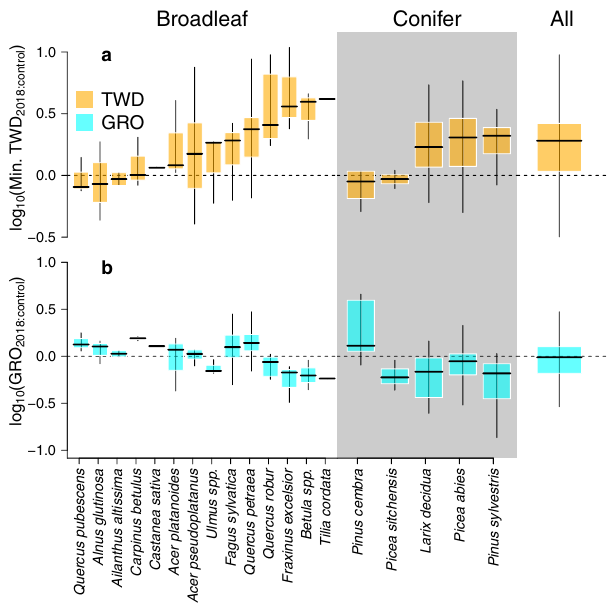
Fig. 2 Species-speci fi c ratios of tree water de fi cit (TWD) during the 2018 heatwave and 2018 annual growth (GRO) relative to control years (2016 – 2017). a , b Boxplots of broadleaf and conifer minimum tree water de fi cit (min. TWD 2018:control ; a ) and annual radial stem growth (GRO 2018:control ; b ) in response to the 2018 heatwave relative to control years. Log transformed ratios are shown to linearise and normalise the response metric. log 10 (TWD 2018:control ) above zero indicates a larger shrinkage was registered during the 2018 heatwave compared to the control years, whereas log 10 (GRO 2018:control ) near zero indicates that stem growth in 2018 was similar to that in control years. Centerlines, box limits, and whiskers represent the median, upper and lower quartiles, and extremes excluding outliers (those further than the 1.5x interquartile range). n = 175 tree stems over 37 highest values of minimum TWD 2018:control were found for oak trees (> 2, Fig. 4b). However, such severe shrinkage was uniquely